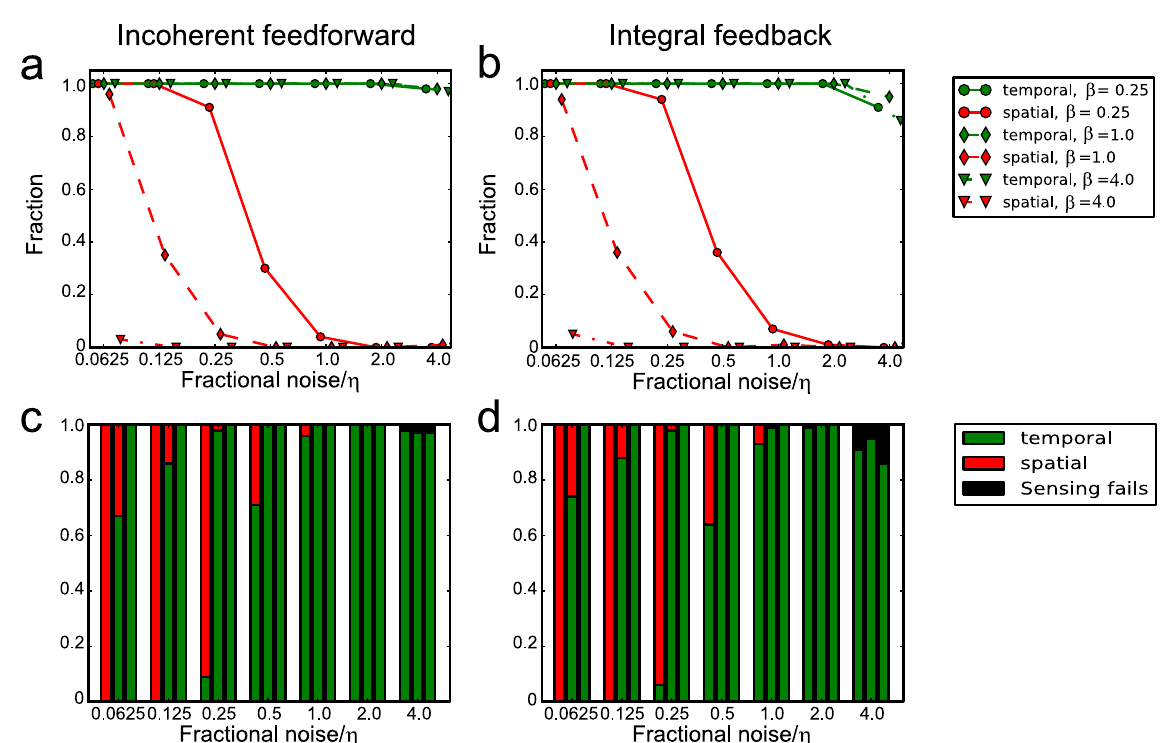
> 0 (green) and O > 0 (red) for all the stochastics runs at different T S